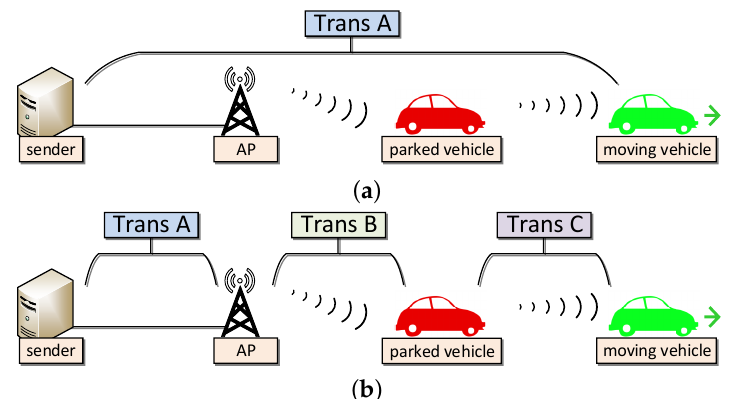
Figure 2. Transport protocol implementation in heterogeneous environments. ( a ) Single transport protocol. ( b ) Joint transport protocols.